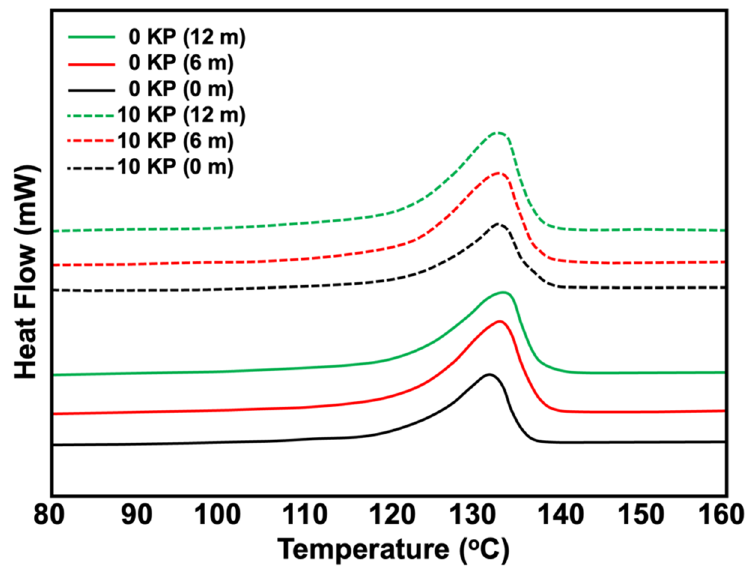
Figure 13. DSC thermogram of KP-filled rHDPE/NR blends before and after 6 and 12 months of natural weathering.